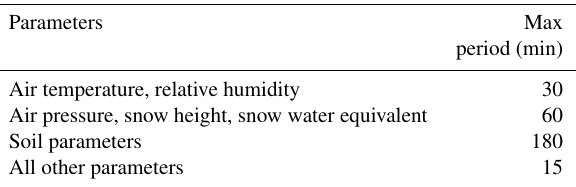
Table 5. Maximum bridged interpolation period of linearly interpo- lated data in the WPS data product generator (DPG).